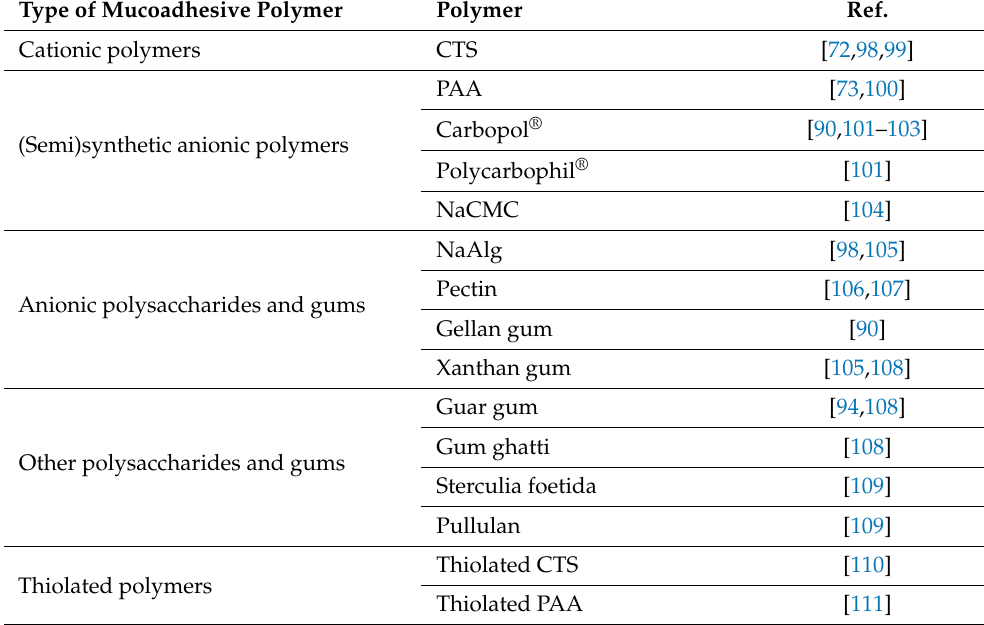
Table 3. Classification of bioadhesive polymers used in the treatment of infections by H. pylori